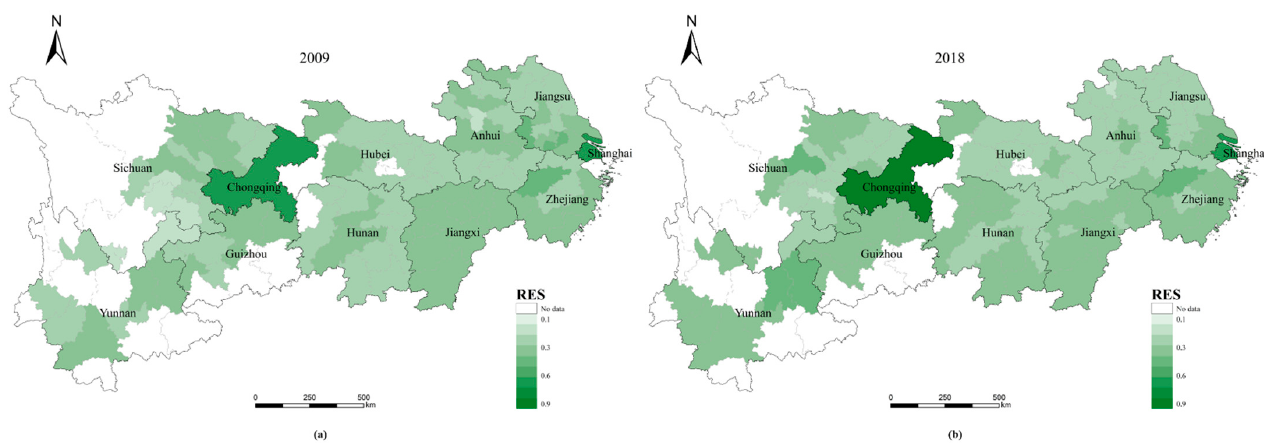
Figure 3. The spatial distribution of the RES index for cities in YREB in 2009 and 2018.